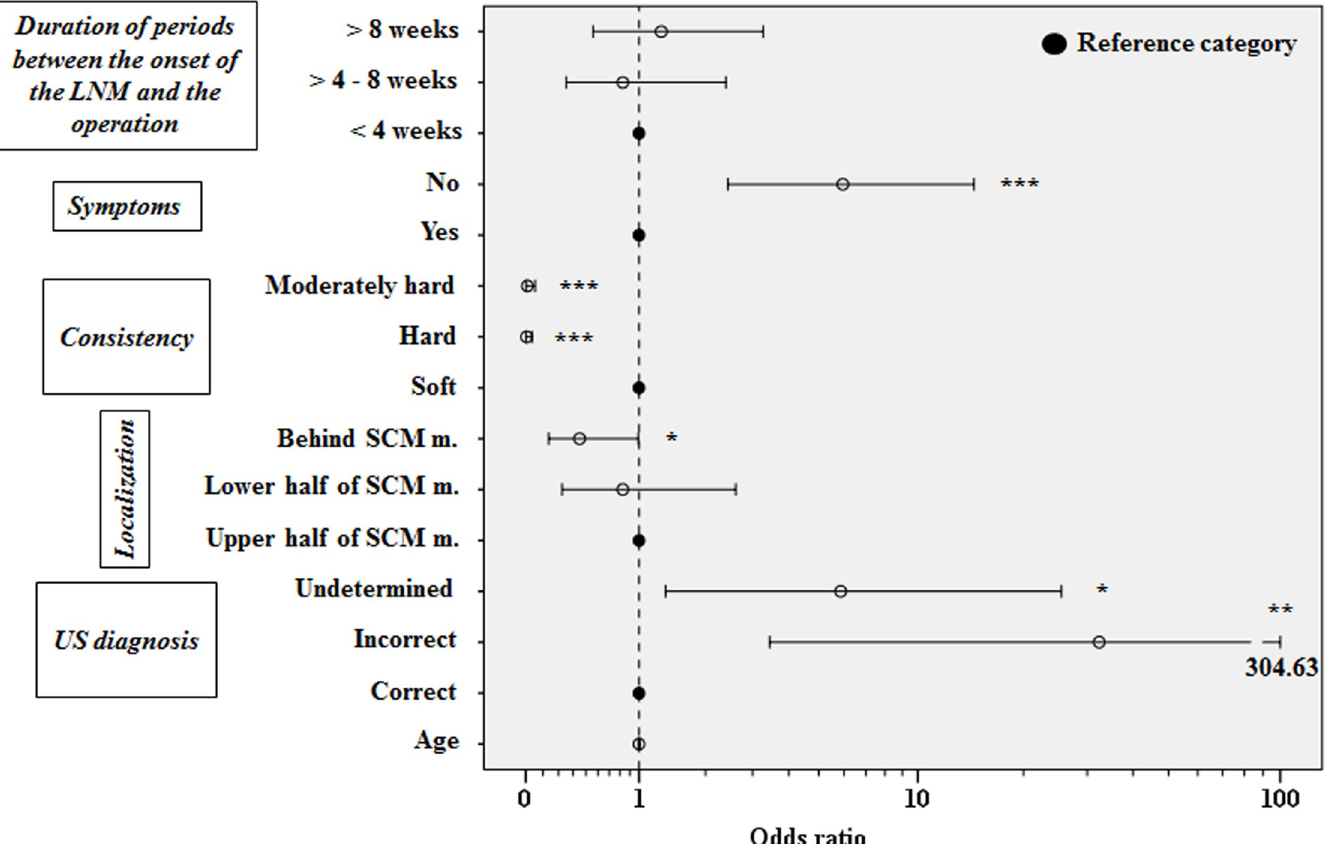
Fig 1. The results of multiple logistic regression analysis with congenital lateral neck masses as an outcome variable. � p < 0.05; �� p < 0.01; ��� p < 0.001 vs corresponding reference category; dotted line indicates value of equal chances for manifestation of selected clinical and US parameters.